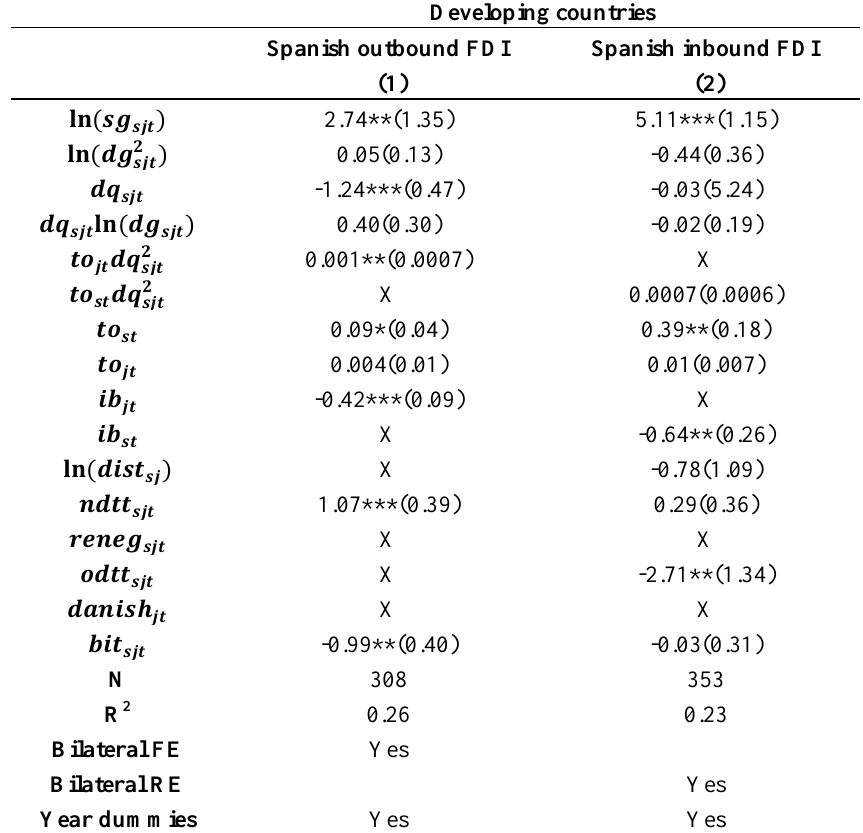
Table 5 : Effect of DTTs on Spanish inbound and outbound FDI: Types of DTTs. Developing